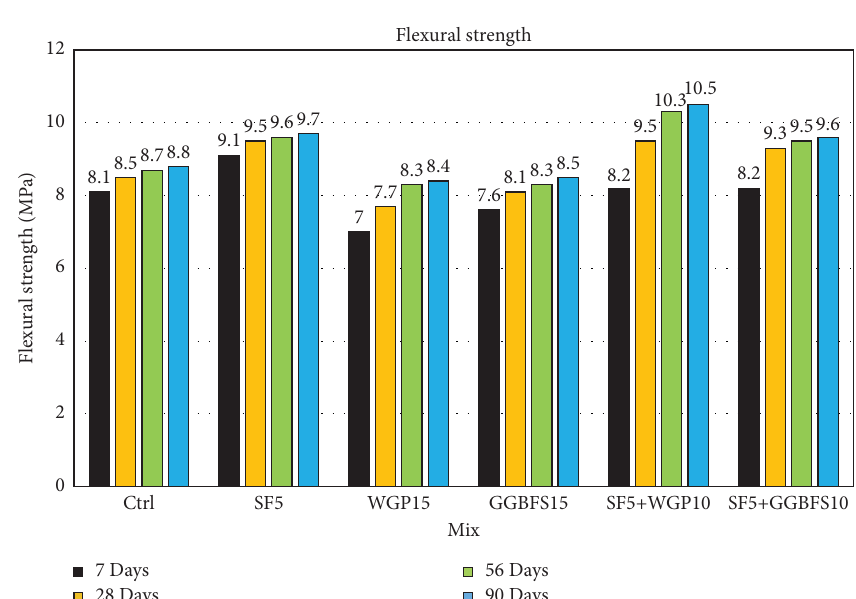
Figure 7: Flexural strength results of concrete mixtures.